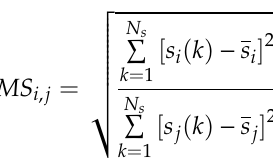
Figure 8. Bearing test rig for analyzing natural bearing failure.